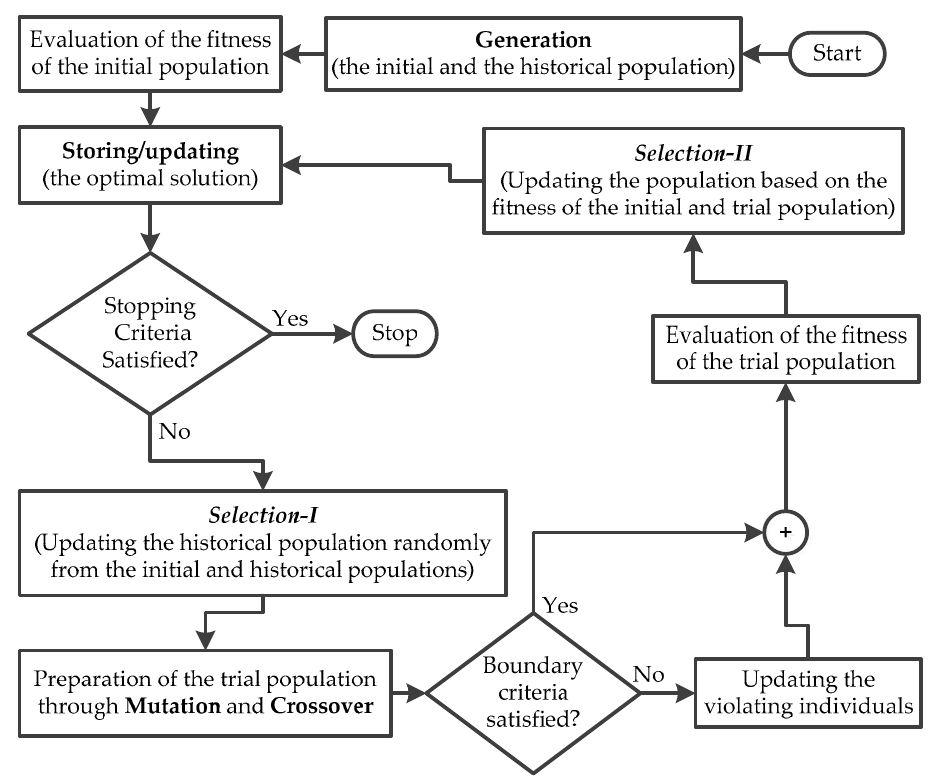
Figure 1. The flowchart for the backtracking search algorithm (BSA).